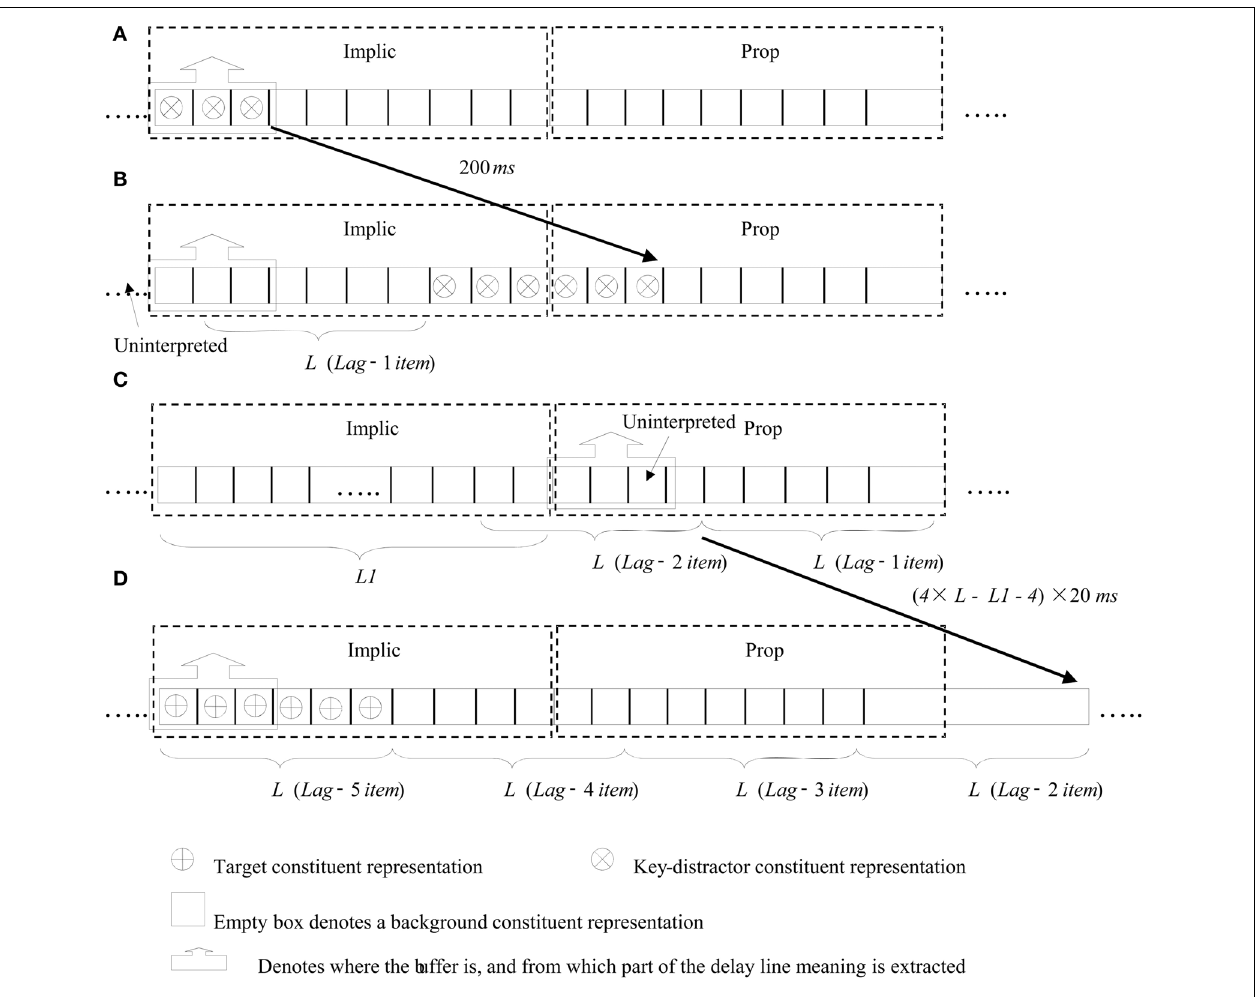
it has seen three implicationally un-interpreted constituent representations; (D) the buffer actually arrives at Implic when the last three constituent representations of the lag-5 item (target) have entered